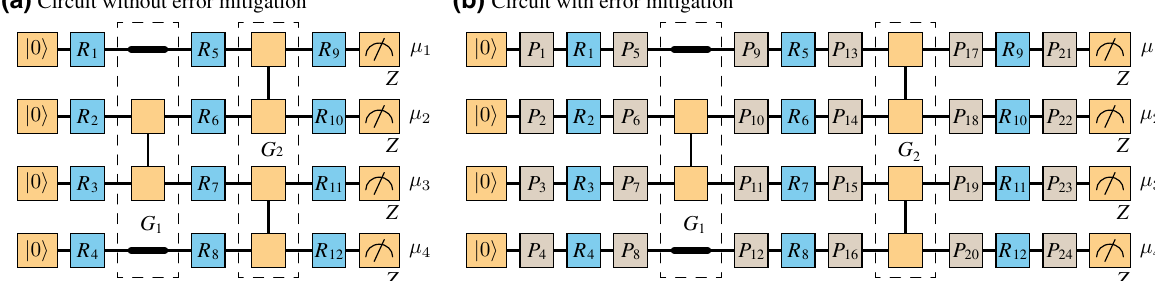
FIG. 1. Simple example of a circuit without and with error mitigation. Each circuit has four qubits and two layers of frame gates G 1 and G 2 (dashed boxes). Note that errors afflict the frame gates and may correlate over arbitrarily many qubits within a box and between boxes (i.e., spatial and temporal errors). Frame operations (orange) include the qubit initialization, frame gates, and measurement. There are three layers of computing gates R i (blue) in each circuit. To implement the error mitigation, two layers of Pauli gates P i (brown) are introduced before and after each layer of computing gates. Usually, single-qubit gates next to each other in the circuit can be combined into one single-qubit gate in the physical